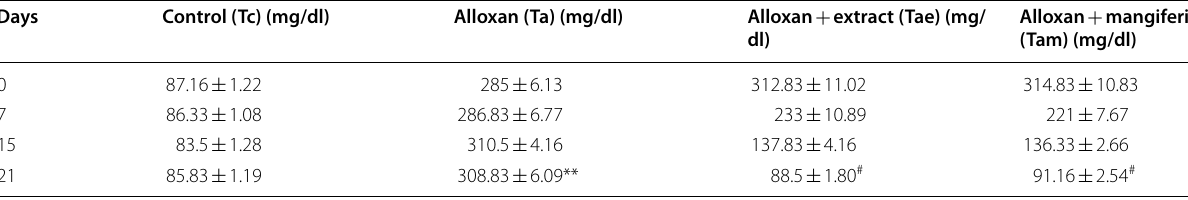
Table 2 Effect of mango peel extract and mangiferin on fasting plasma glucose level in the alloxan-induced type I diabetic rat